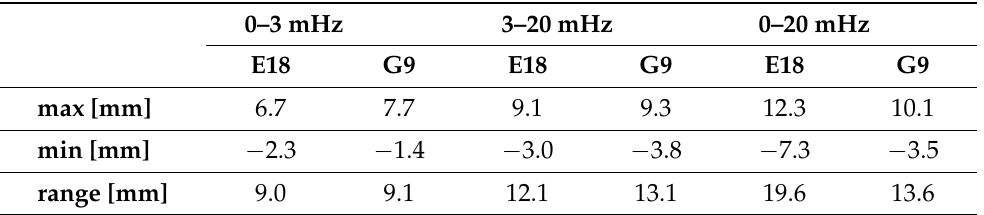
Table 5. Maximum double-difference phase observation multipath errors determined from the decomposition of signals for specified